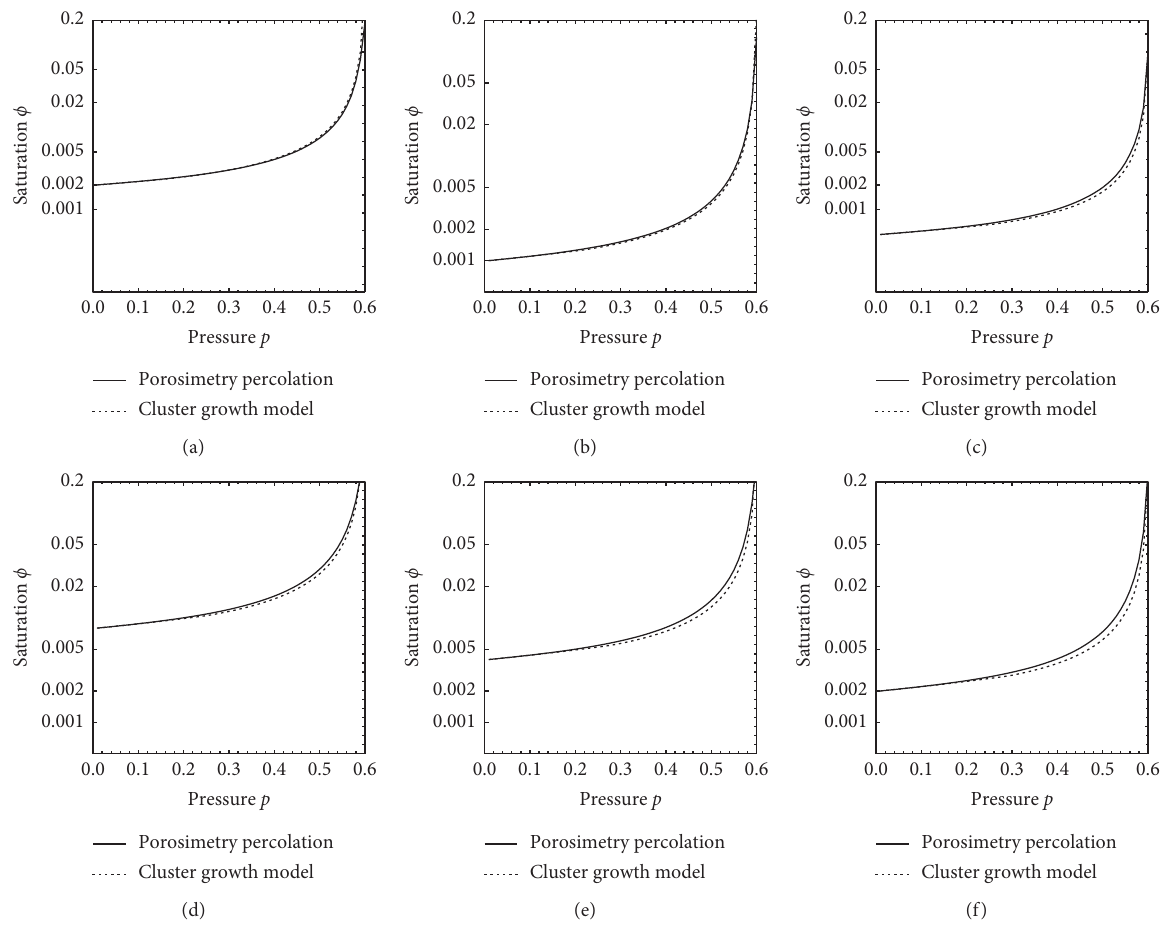
Figure 12: ϕ � Φ / L 2 (expected cluster size scaled with the lattice size) calculated using both the cluster growth model and porosimetry percolation simulations. 1-sided invasion of lattices having (a) L � 500 ( Φ � 2000, I � 2000). 4-sided invasion of lattices having (d) L � 500 ( Φ L � 2000 ( Φ 0 0 I Table 2: Mean and RMS of the relative errors ( Φ Case | Φ 1-sided L � 500